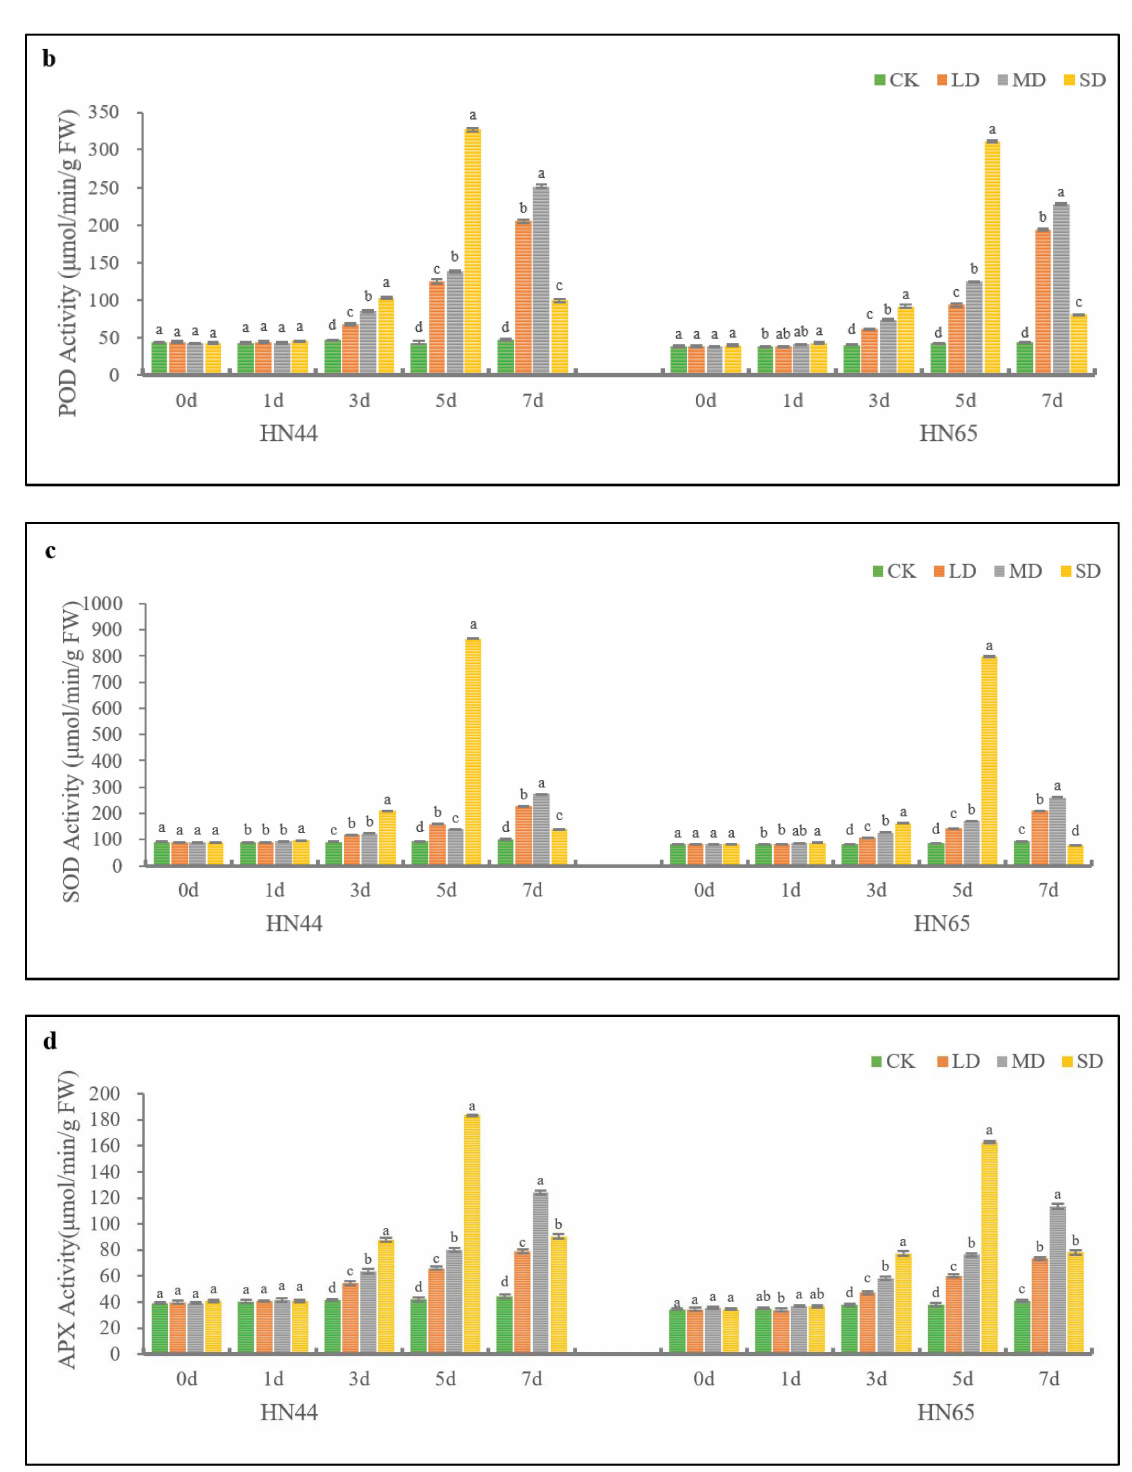
Figure 2. Changes in activities of CAT ( a ), POD ( b ), SOD ( c ), and APX ( d ) of HN44 and HN65 over time under different drought degrees. Different letters in treatments indicate significant differences according to Duncan’s single factor variance test at the 5% level, and data are presented as mean ± SE (standard error) ( n =